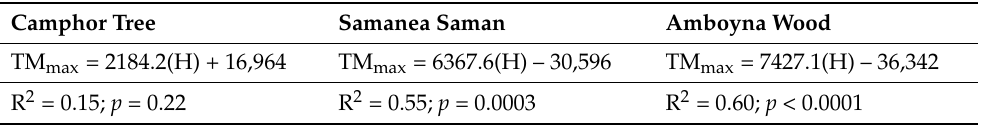
Table 5. Regression equations for the relationship between TM max and tree height (H) in near- saturated soil